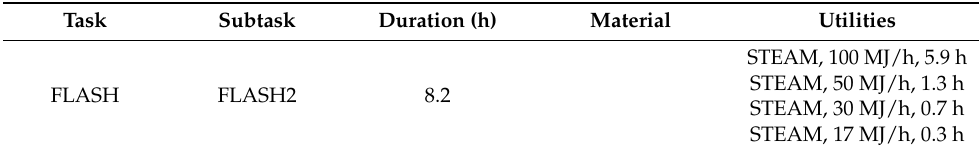
Table 2. Consumption profile for STEAM in FLASH2